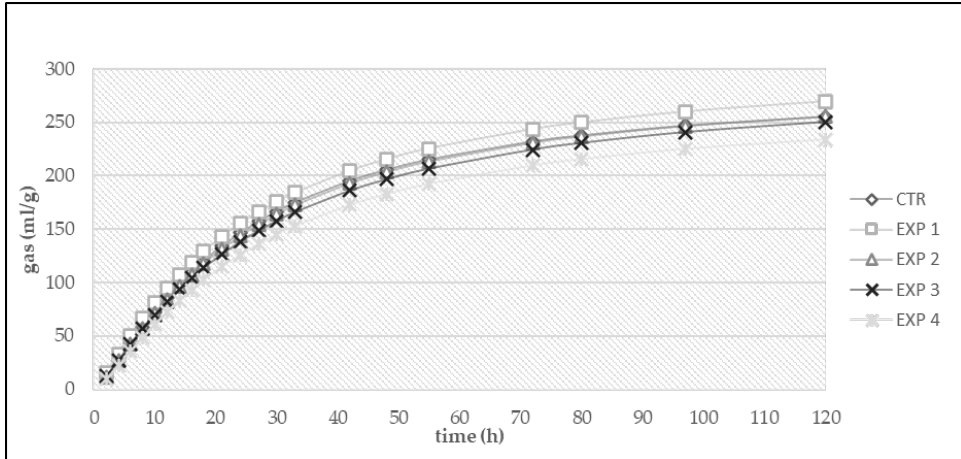
Figure 1 and 2. In vitro gas production and fermentation rate over time in control and experimental 181 diets with buffalo inoculum . Figure 2. In vitro fermentation rate over time in control and experimental diets with buffalo inoculum.